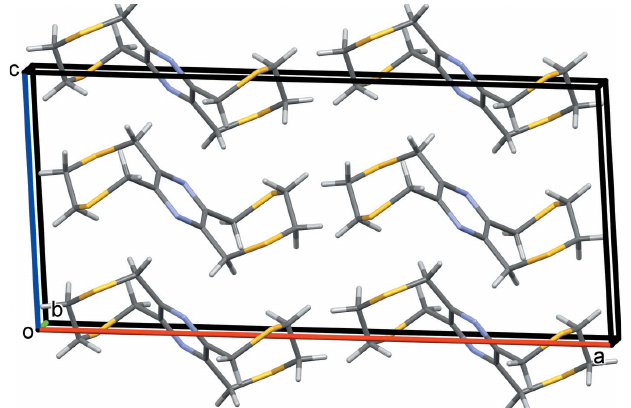
Figure 6 Crystal packing of L2 viewed along the b axis. The molecules stack in columns up the c